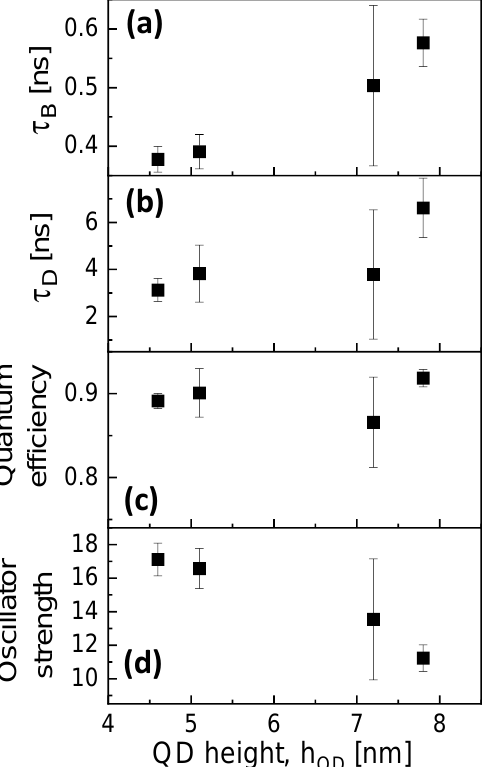
Figure 4. Dot-size dependent QD optical parameters extracted from biexponential fits of the time- dependent exciton peak intensity using the approach of Narvaez et al. [34]. Radiative lifetimes of ( a ) bright and ( b ) dark states, ( c ) quantum efficiency, and ( d ) oscillator